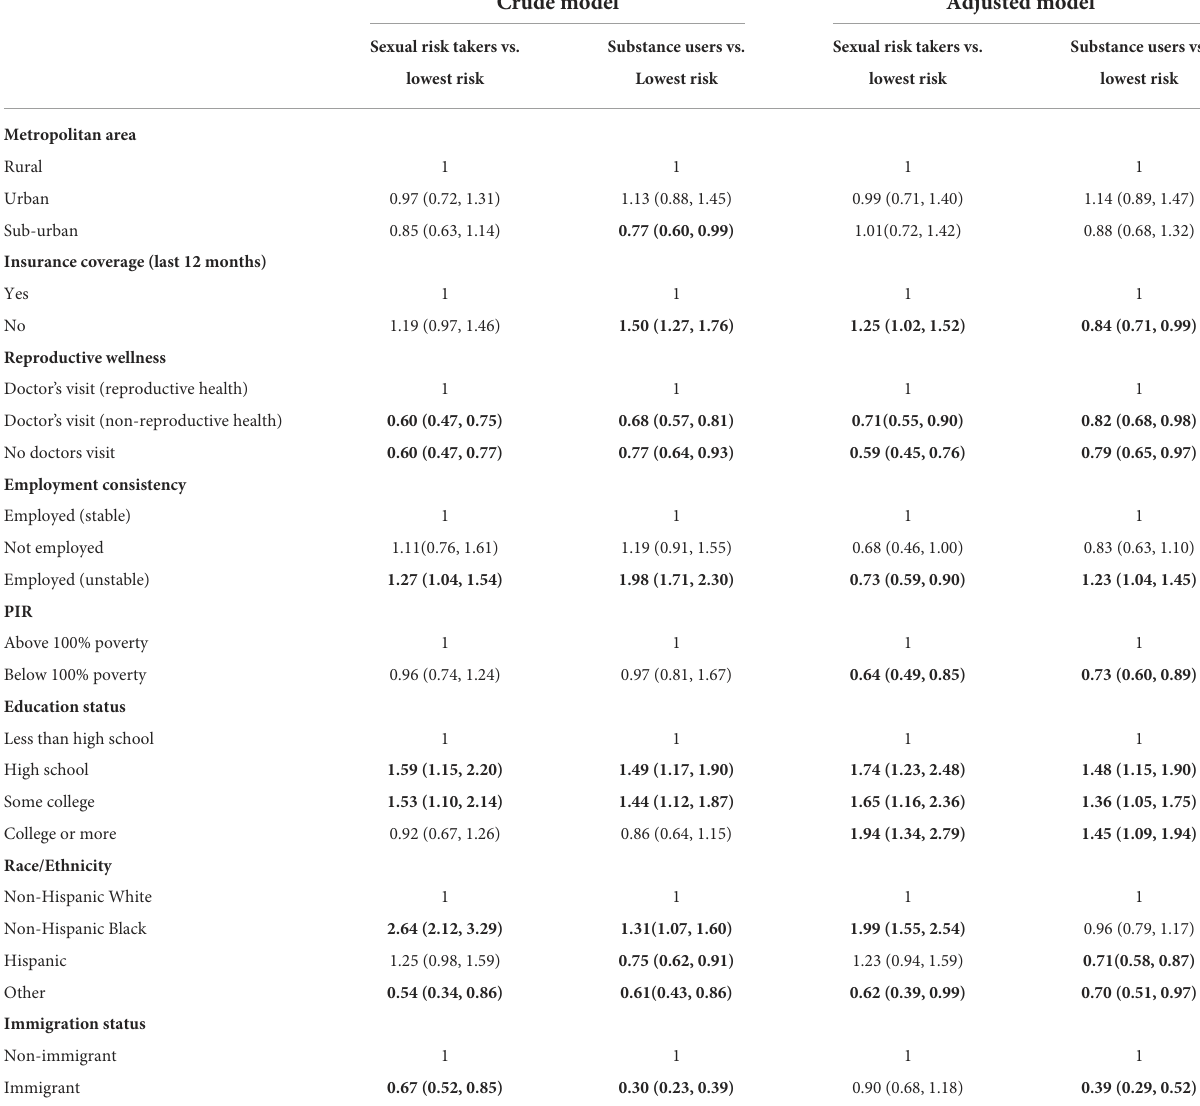
TABLE 4 Social determinants of health and correlates of men’s preconception health latent class membership (N = 10,223). Crude model Adjusted model Sexual risk takers vs. Substance users vs. Sexual risk takers vs. Substance users